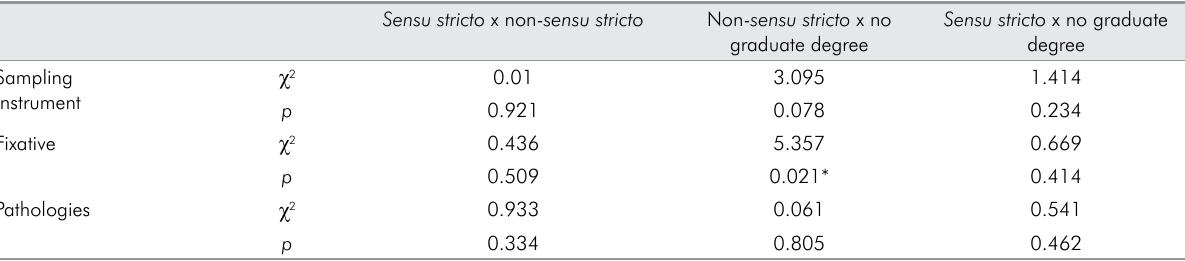
Table 3. Values of χ 2 and p after comparisons between education levels and the variables of sampling instrument, fixative and pathologies for which EC is